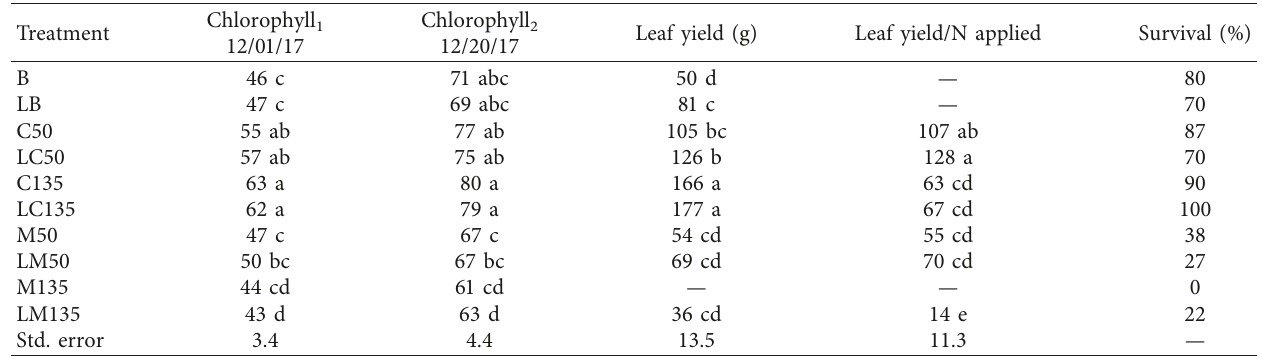
Table 3: Kale yield and quality